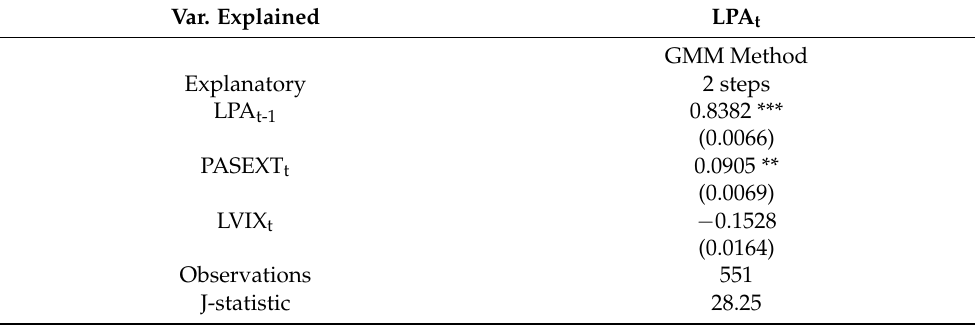
Table 1. Econometric model